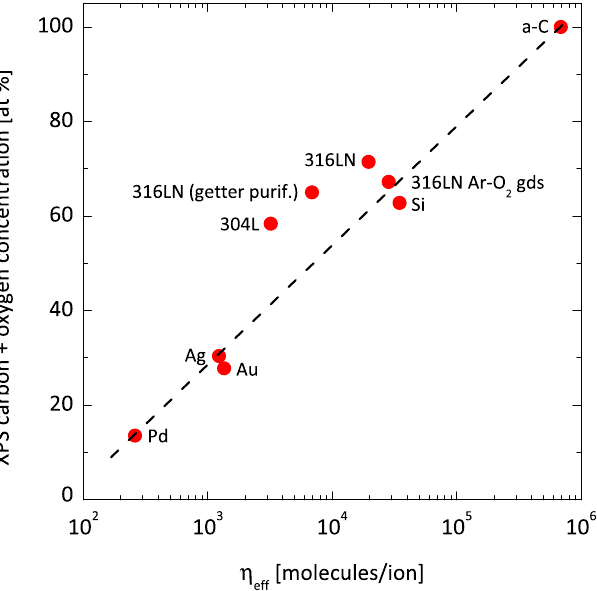
FIG. 5. Correlation of heavy-ion induced desorption yields, measured with accelerator-type vacuum chambers at LINAC 3, and the XPS carbon þ oxygen surface-concentration of their corresponding samples, which were in situ investigated after a 300 (cid:3) C bakeout in UHV. Various coatings (Pd, Au, Ag, Si, a-C) on stainless steel substrates are compared to bare stainless steel (316LN, 304L) including surface cleaning methods as Ar - O glow discharges [5] and getter purification. The dashed line only indicates the possible